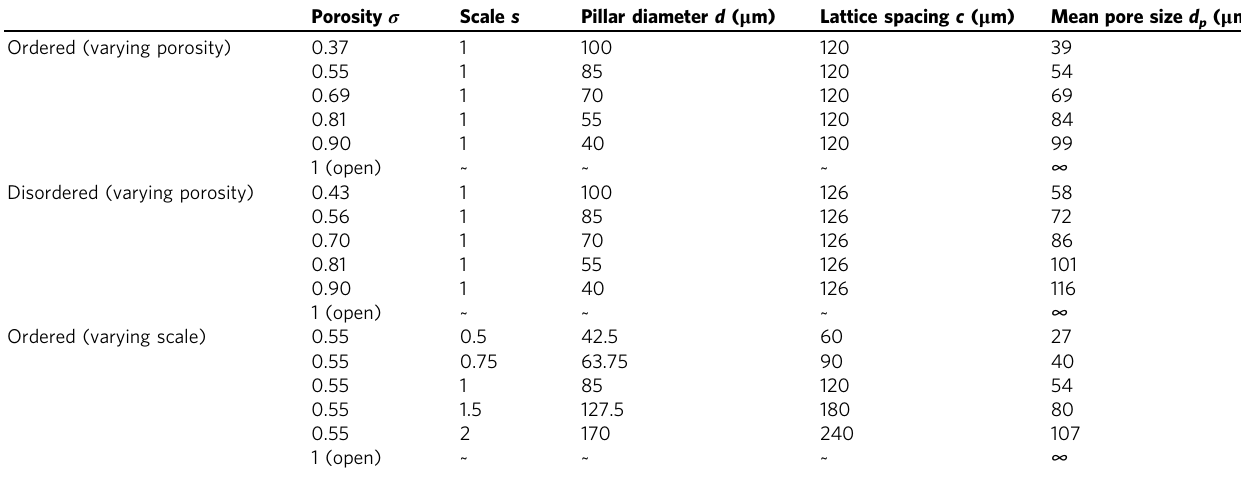
Table 1 Geometric speci fi cations of the micro fl uidic model porous media used in experiments. Porosity